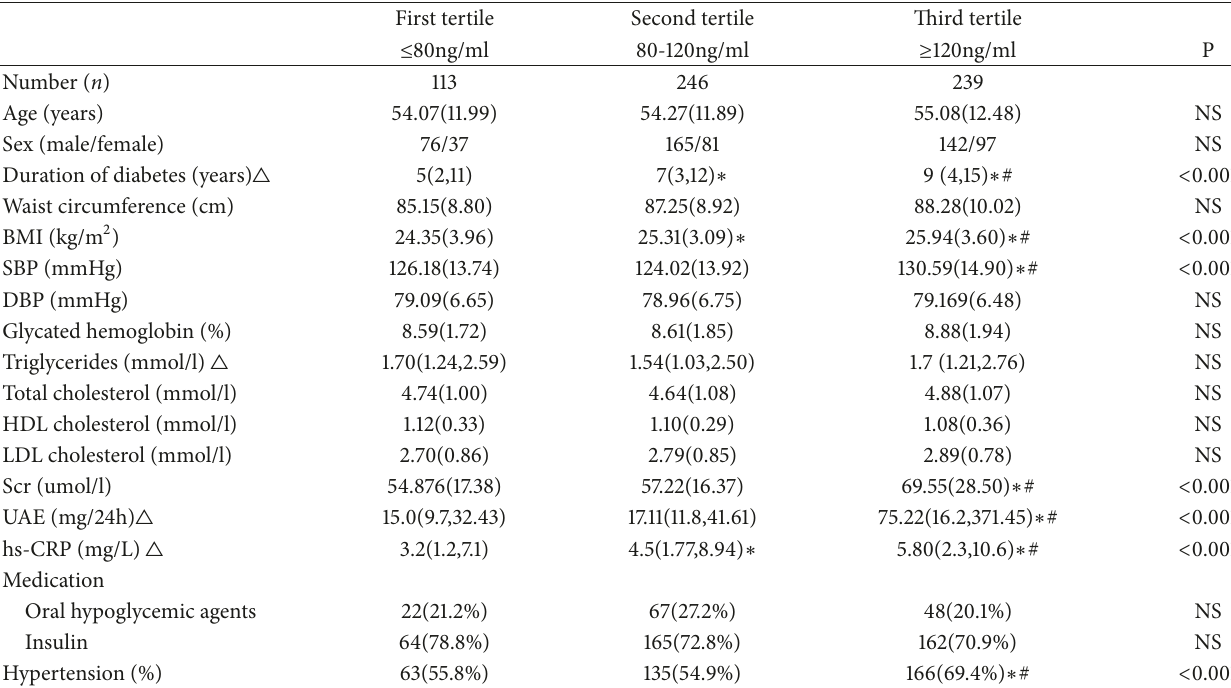
Table 2: Characteristics of all type 2 diabetic patients by chemerin